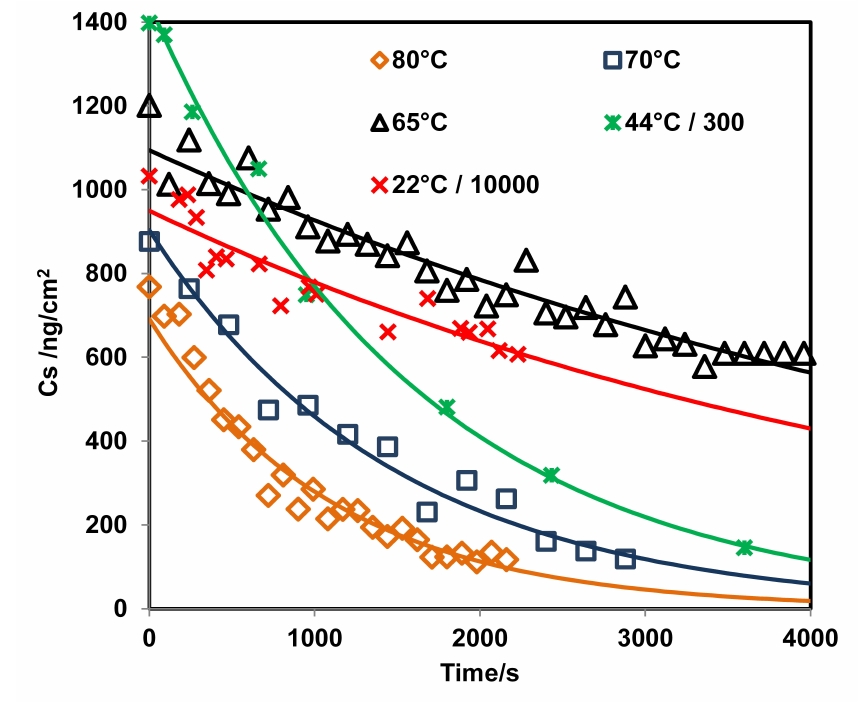
Figure 4. Prediction of Cs using the PLS model vs. time for RDX on SS at different